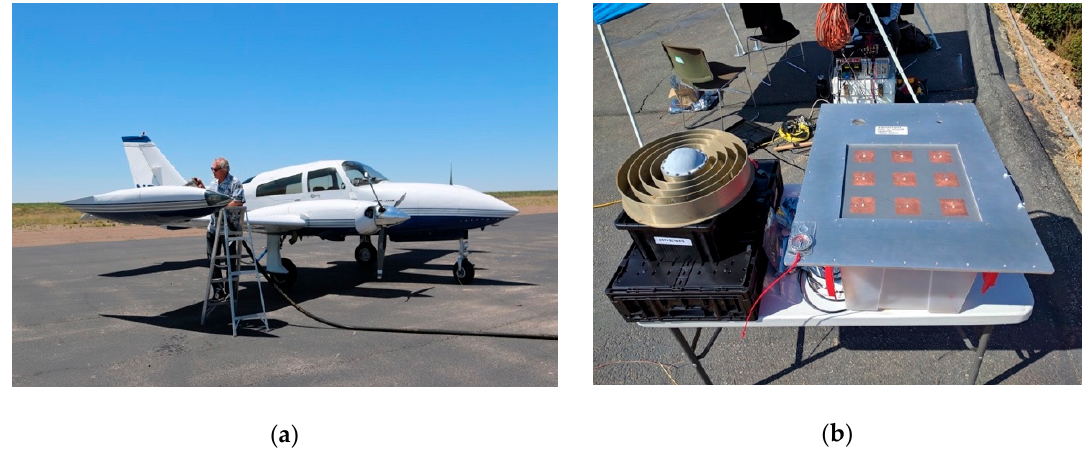
Figure 1. ( a ) Keystone’s Cessna 310 used for all three flights. ( b ): Antenna calibration experiment.